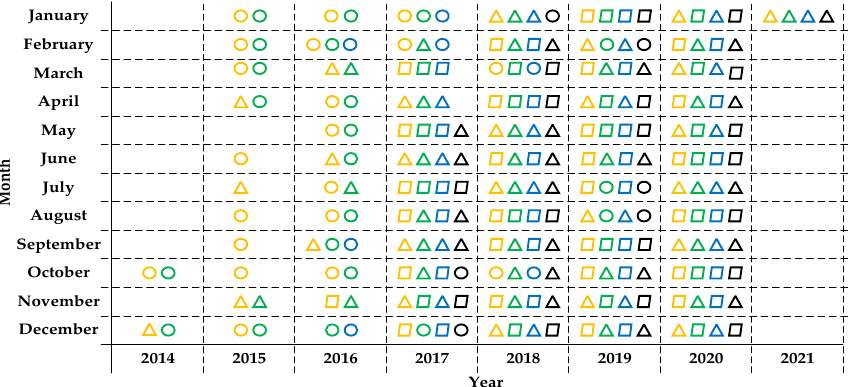
Figure 4. Distribution and monthly availability of the Sentinel-1 images used for the analysis of the dynamics of Burlan and Pomacochas Lakes from 2014 to 2021. The geometric figures represent the number of images available in a month, where circles, triangles, and parallelograms represent 1, 2, and 3 images, respectively. In addition, the colour of each represents the combination of the direction of passage and polarization, where orange, green, blue, and black represent the combinations of DVV, AVV, DVH, and AVH, respectively. A total of 517 Sentinel-1 images were analysed for each study lake from 2014/10/06 to 2021/01/29 (Table 1). In addition, due to the classification using CART, RF, and SVM, 3 products were obtained per image, generating a total of 3102 water masks for both lakes. Table 1. Number of SAR images used to generate the water masks of Burlan and Pomacochas Lakes using CART, RF, and SVM. Lake